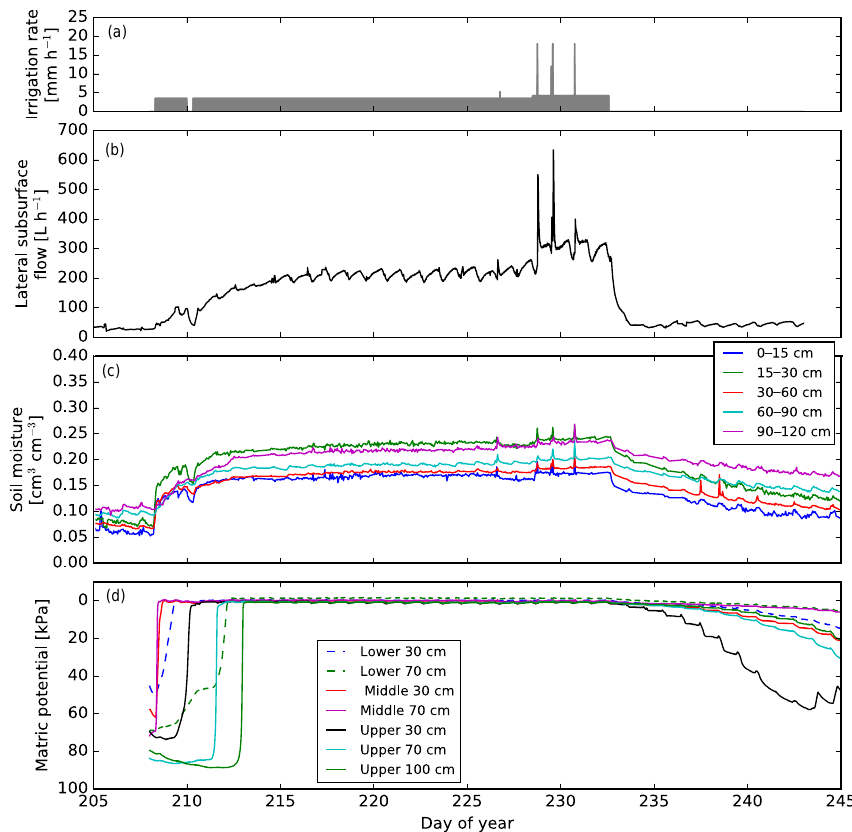
Figure 2. Temporal dynamics over the experiment of the irrigation rate (a) , lateral subsurface flow measured at the hillslope trench (b) , soil moisture measurements averaged for five measurement depths (c) and matric potential measurements for the three tensiometer nests (d) .